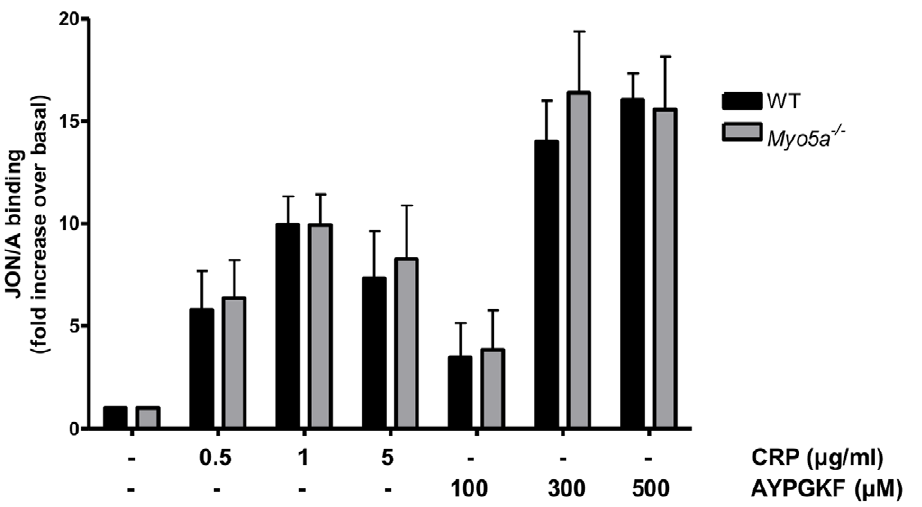
Figure 5. No difference in integrin a IIb b 3 activation in myosin Va-deficient platelets. Wild-type and Myo5a 2 / 2 mouse platelets were stimulated for 10 min with the indicated concentrations of collagen-related peptide (CRP) and the PAR4 agonist AYPGKF. JON/A binding to the